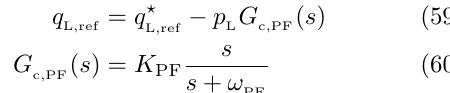
Figure 18: Open loop frequency responses for p PA different linearisation